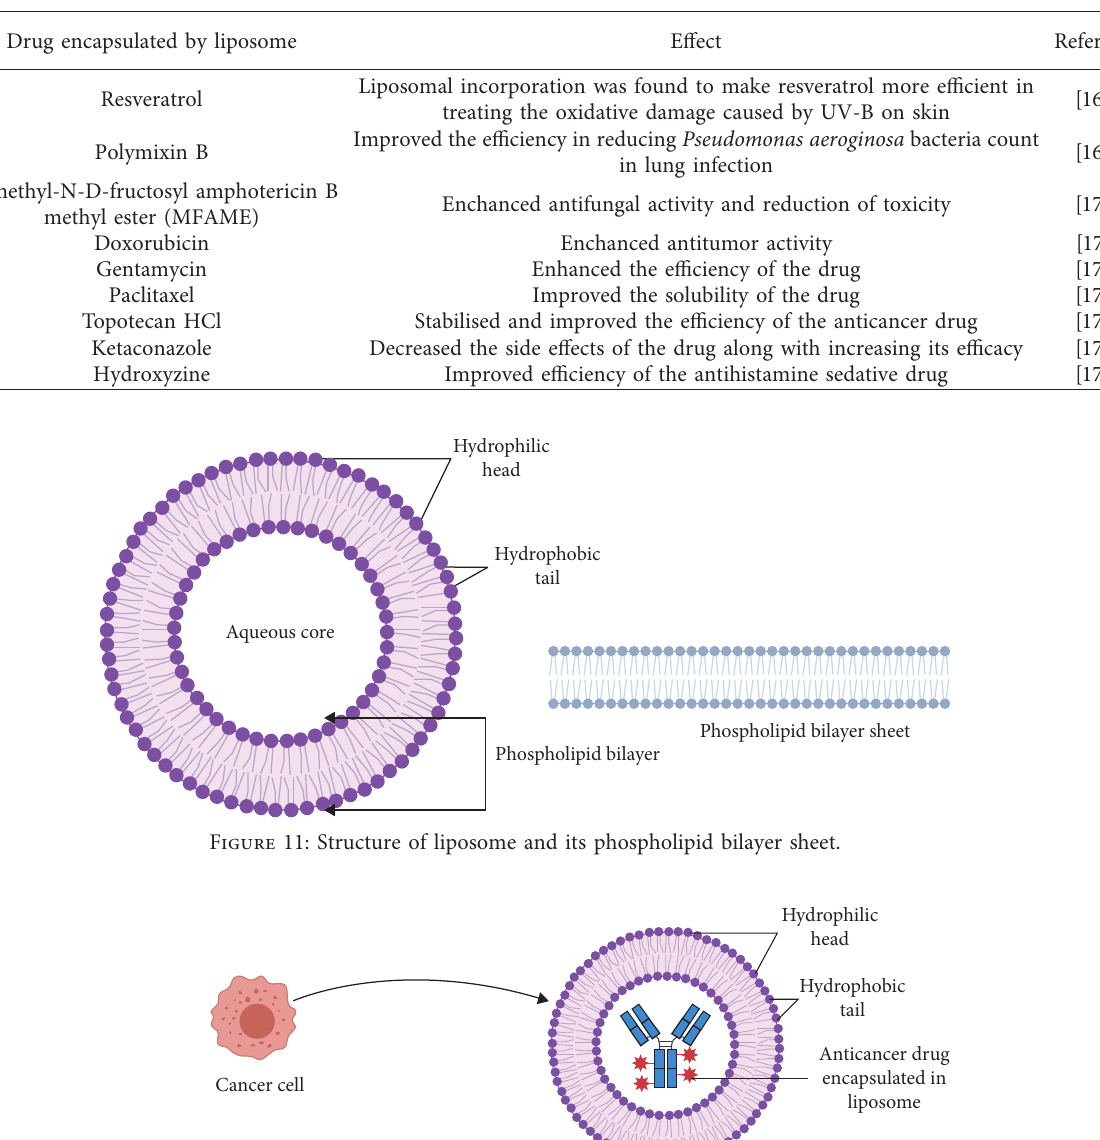
Table 7: Effects of encapsulation of the drug by liposome on its